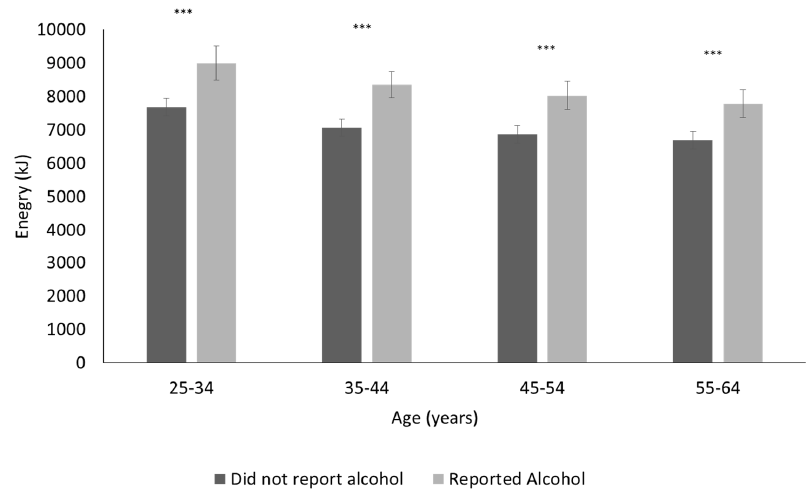
Figure 4. Mean (95% Confidence Interval) energy for women reporting alcohol intake compared to those not reporting alcohol on the day of the survey from the three national nutrition surveys